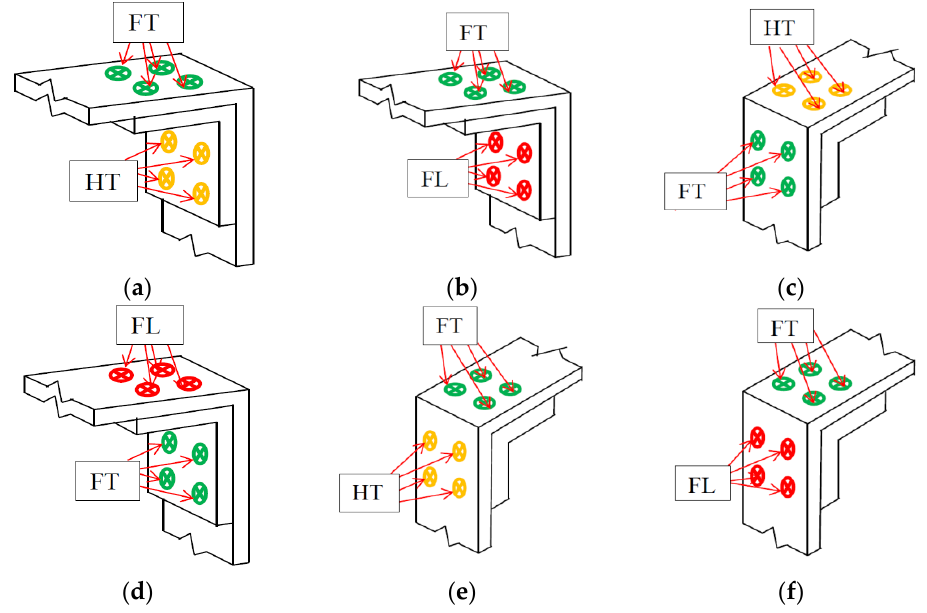
Figure 4. Bolt loosening cases ( a ) BL1, ( b ) BL2, ( c ) BL3, ( d ) BL4, ( e ) BL5 and ( f ) BL6.